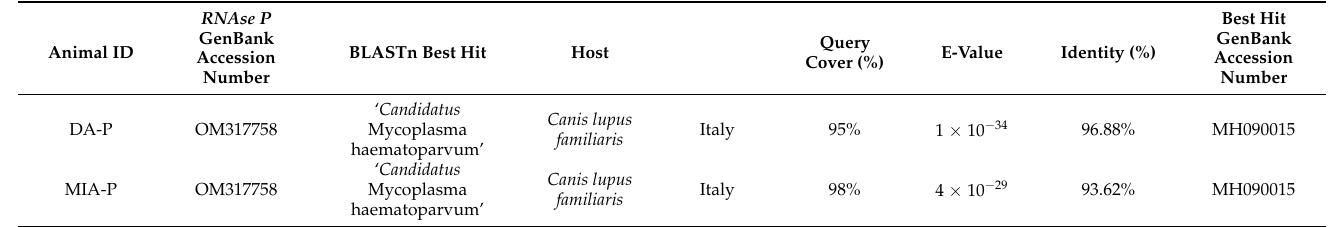
Table 4. BLASTn analysis of each partial hemoplasma RNAse P sequence obtained from free-ranging tapirs from the Brazilian biomes of Cerrado and Pantanal.